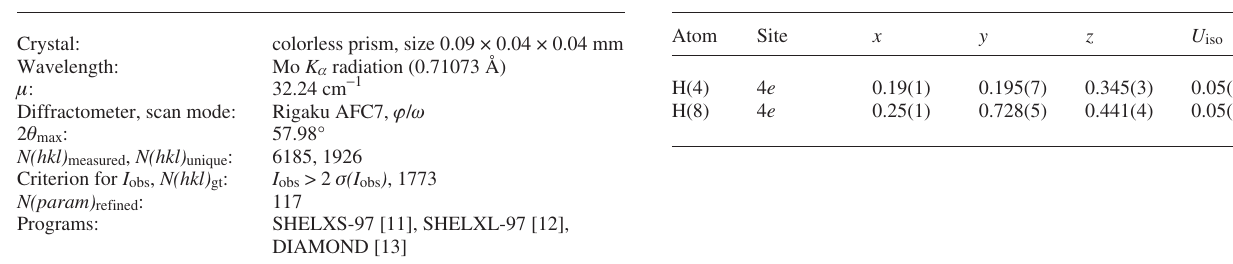
Table 2. Atomic coordinates and displacement parameters (in Å 2 ) . Table 1. Data collection and